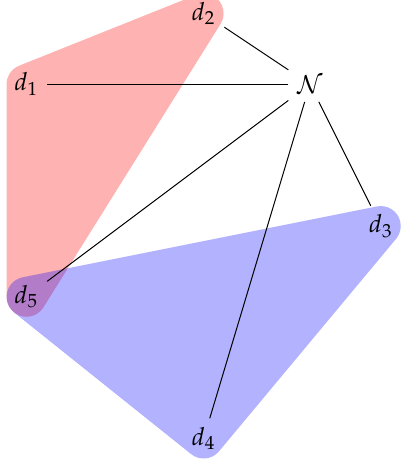
Figure 2. Two sub-clusters providing different services S 1 and S 2 with different